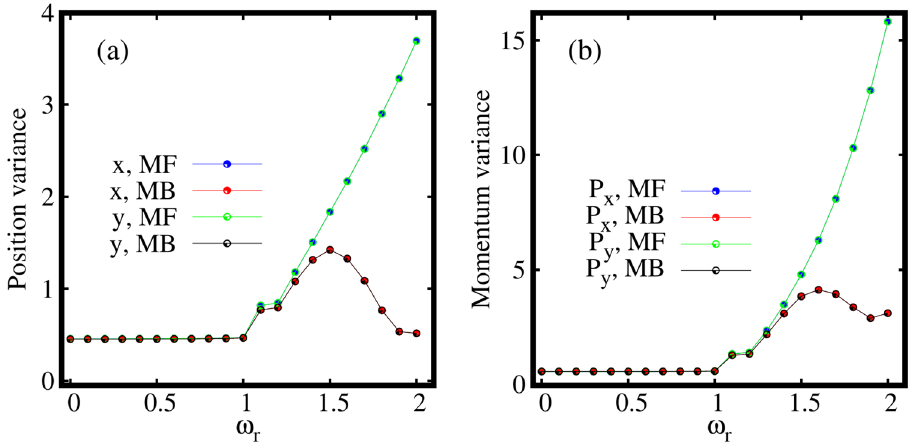
Figure 13. Dependence of the the many-particle position and momentum variances on the rotation in the four- fold symmetric trap. ( a ) depicts the position variances 1 N (cid:31) 2 ˆ X , 1 N (cid:31) 2 ˆ Y and ( b ) displays momentum variances 1 N (cid:31) 2 ˆ P 1 2 M = 4 self-consistent orbitals] and at the mean-field level (MF) [ M = 1 N (cid:31) ˆ P Y at the many-body level (MB) [ self-consistent orbital]. All quantities shown are